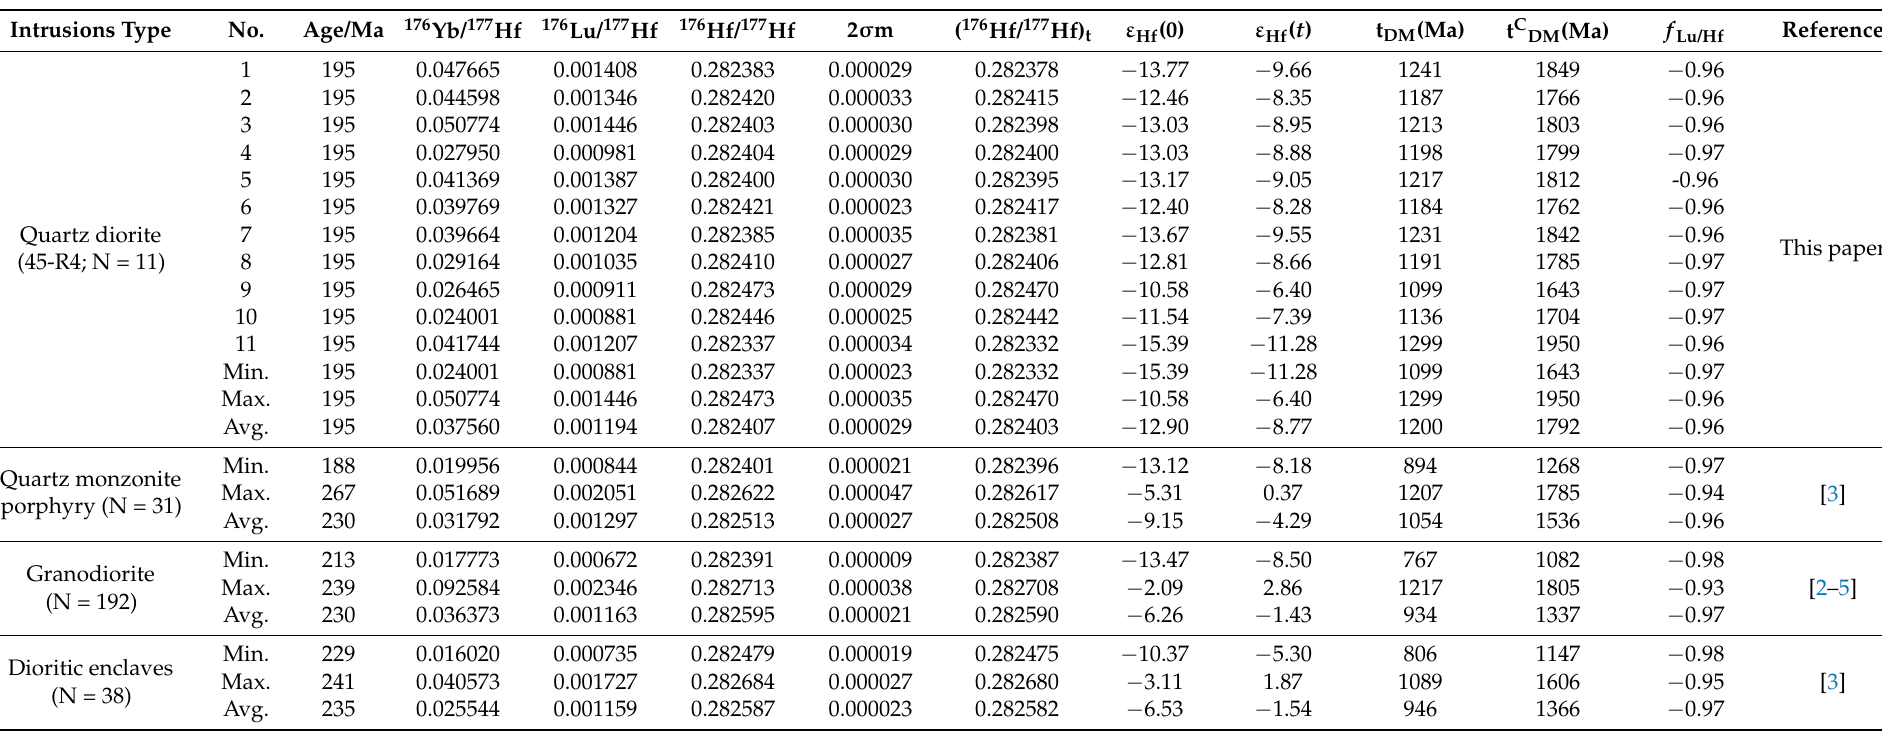
Table 2. Zircon Hf isotopic compositions of quartz diorite, granodiorite, quartz monzonite porphyry, and dioritic enclave in the Yangla Cu-W polymetallic